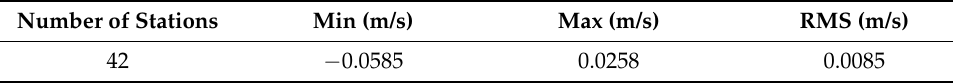
Table 6. Seven days summary results of DORIS orbit check.